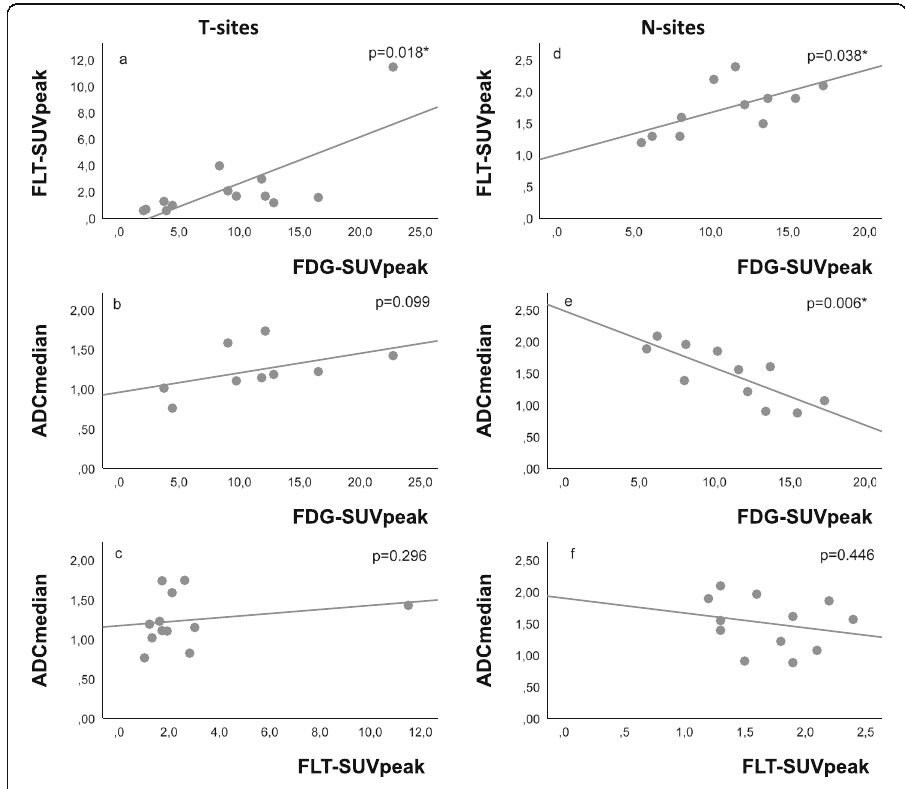
Fig. 2 Correlations of FDG-SUV peak , FLT-SUV peak , and ADC median in T-sites ( a – c ) and N-sites ( d , e ). FDG-SUV peak vs. FLT-SUV peak were positive correlated in T-sites ( a ) and N-sites ( d ). FDG-SUV peak vs. ADC median was not significantly correlated in T-sites ( b ), but significantly negative correlated in N-sites ( e ). ADC median vs. FLT-SUV peak were neither correlated in T-sites ( c ) nor N-sites ( f ). Significant correlations ( p <0.05) are marked with